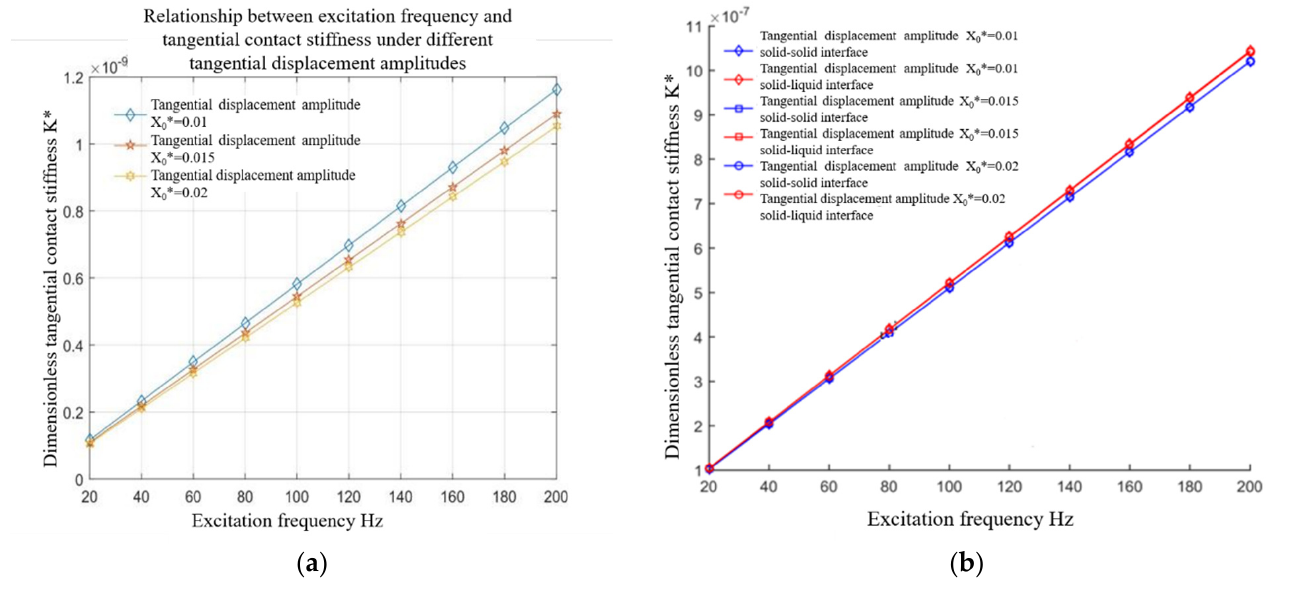
Figure 6. Relationship between the tangential contact stiffness and the excitation frequency under different tangential displacement amplitudes. ( a ) Fluid contact characteristics, ( b ) solid − solid and solid − liquid bonding face ratio.